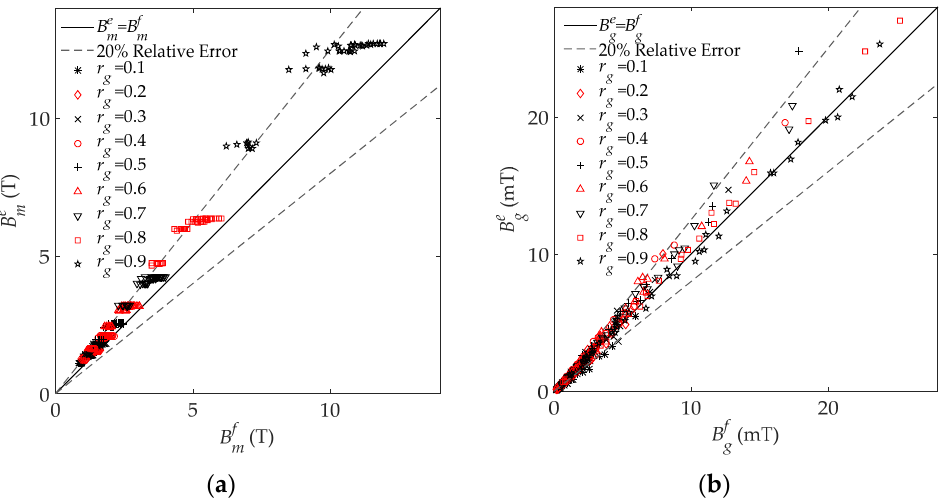
Figure 9. ( a ) FEM-simulated B f m and analytical B e m under all 405 air gap settings. If the FEM result is the same as the analytical result, the point should fall on the black perfect line B e m = B f m ; ( b ) FEM-simulated B f g and analytical B e g under all 405 air gap settings. If the FEM result is the same as the analytical result, the point should fall on the black perfect line B e g = B f g .